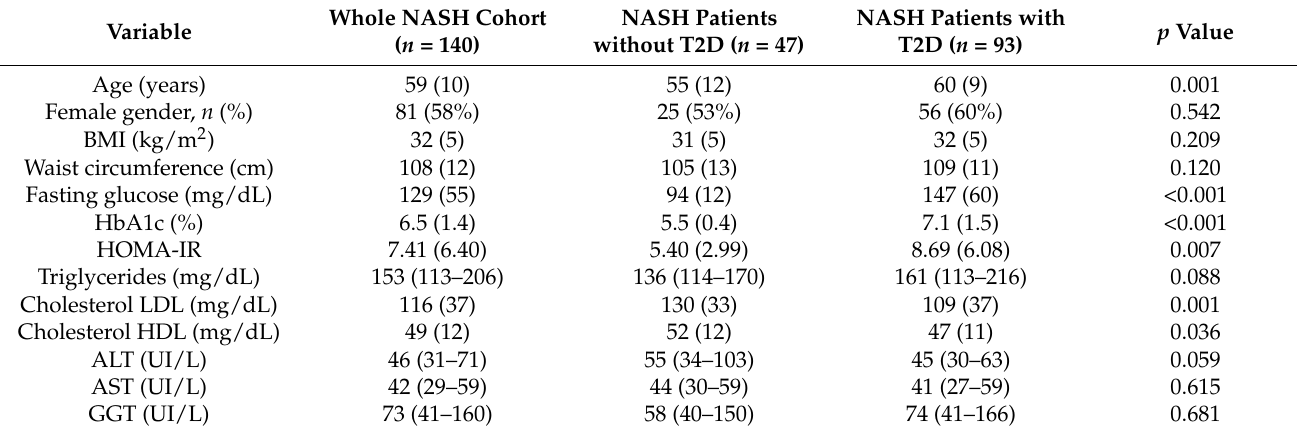
Table 1. Clinical characteristics of the study cohort and subdivided respect to T2D